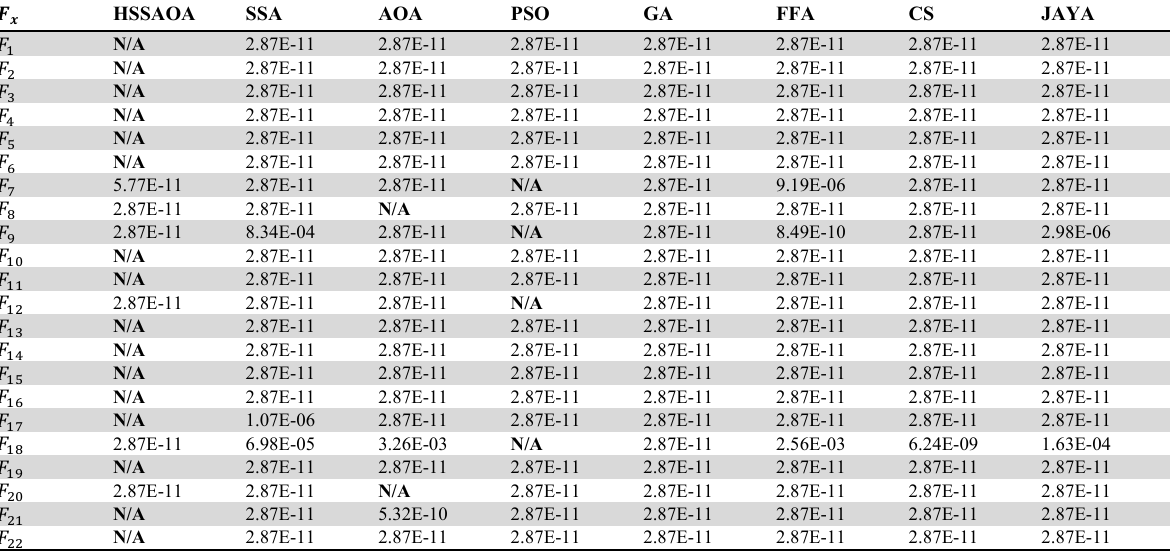
According to the results in Table 3, the hybrid algorithm was successful in a total of 16 benchmark functions. 8 of them were unimodal benchmark functions and the other 8 were multimodal benchmark functions. In the benchmark functions that HSSAOA was successful, the second successful algorithm was AOA with 15 benchmark functions. In benchmark functions where HSSAOA could not reach the best results, AOA (in 2 benchmark functions) and PSO (in 4 benchmark functions) achieved the best results. Other algorithms did not achieve the best results in any benchmark function. Table 4 shows the wilcoxon rank sum test results ( 𝑝 values ) of the analysis performed according to Group 1. According to Group 1, wilcoxon rank sum test 𝑝 values (N/A = not applicable)